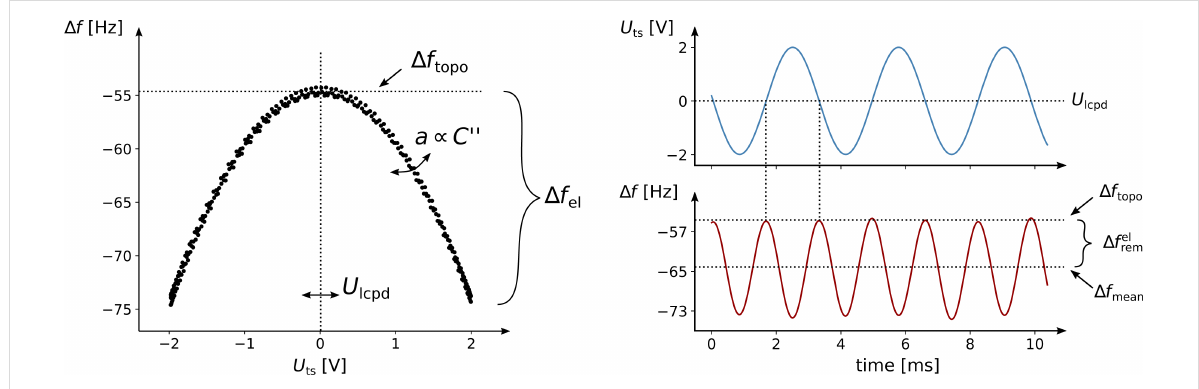
Figure 1: A modulation of the tip–sample bias U ts leads to a response in the frequency shift Δ f . The time-resolved measurements of both signals are shown on the right, the resulting Kelvin parabola on the left. From this information, the controller continuously estimates the contact potential differ- ence U lcpd , the capacitance gradient C ′′ , and the frequency shift due to the topography alone, Δ f topo . Sample: Single-layer graphene on SiO 2 ; Tip: Olympus